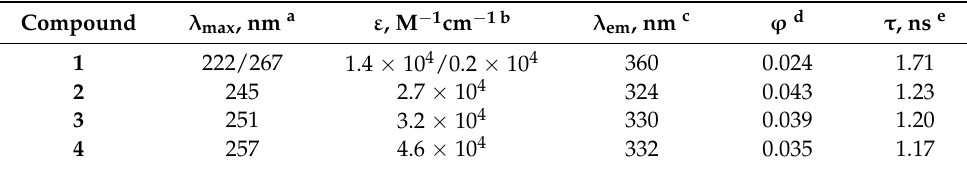
Table 1. Optical properties of perfluorinated para